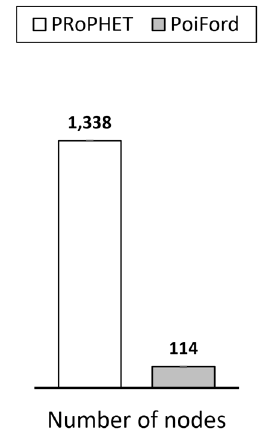
Figure 6. The average number of nodes for which encounter history is maintained.